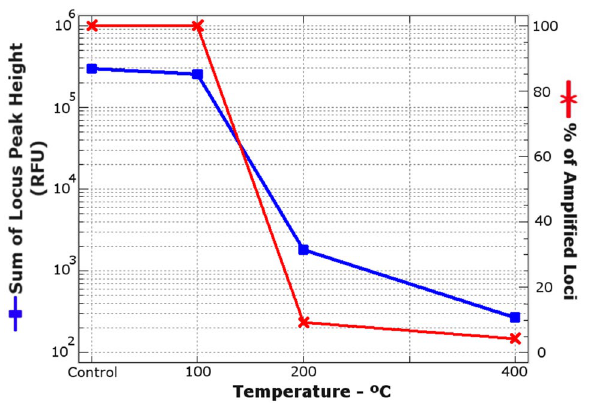
Figure 1. Effect of temperature on STR amplification. Sum of locus peak heights in relative fluorescence units (RFU) and percentage of amplified loci against temperature (without incineration—control, 21 °C- and with incineration at 100, 200 and 400 °C for 60 min). Note that the sum of peak heights is represented to the power of 10 to improve the visualization of the figure.